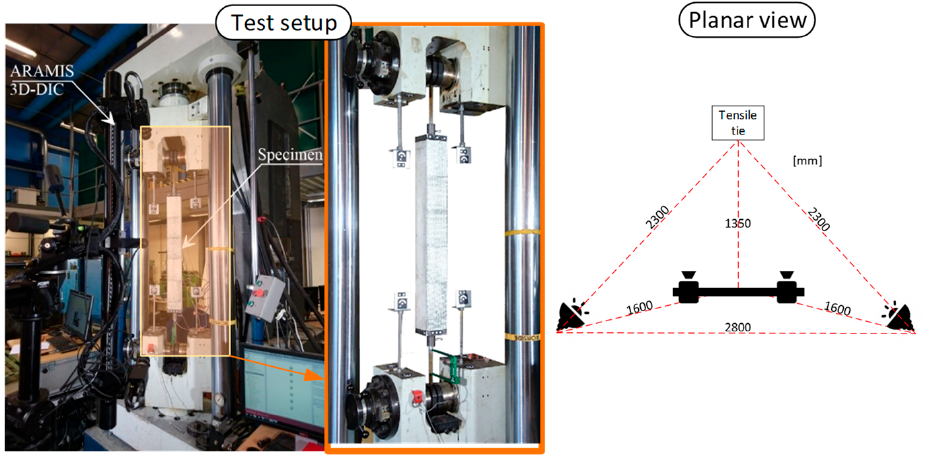
Figure 6. Test setup by DIC system [images taken by Jenny Lindmark, Master thesis, LTU] .